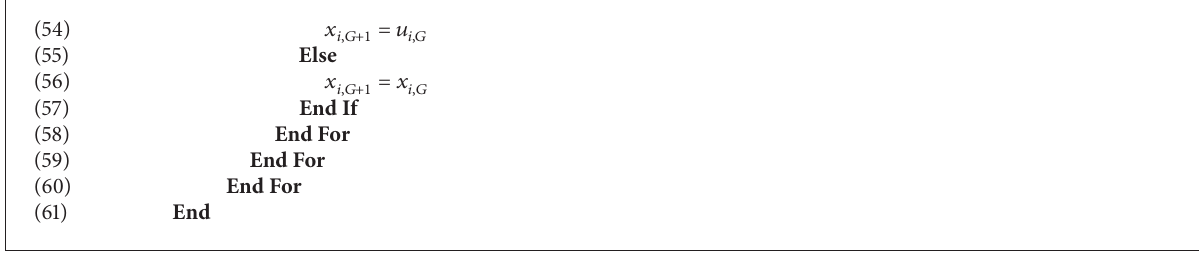
Algorithm 1: Pseudocode of TSDE.